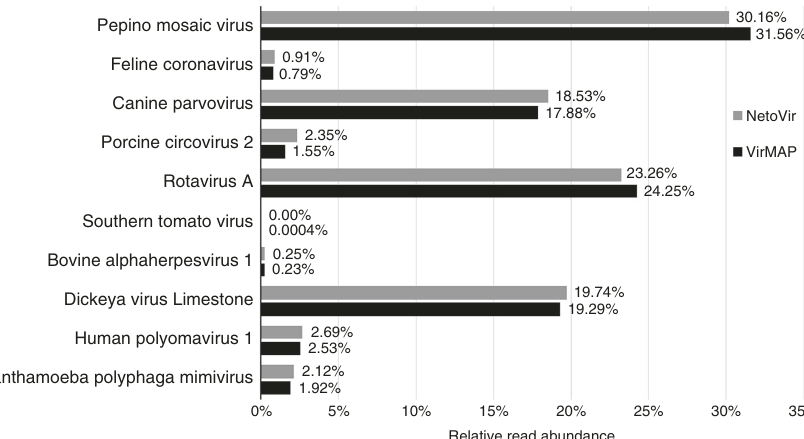
Fig. 3 VirMAP analysis of an external mock community. A mock virome control sample (SRR3458562) recently reported 15 was processed with VirMAP. A total of 5,969,272 reads (32.96%) were classi fi ed as being of viral origin across 10 distinct viral lineages which included the nine viral constituents of the mock community. Additionally, one putative contaminant virus was identi fi ed: southern tomato